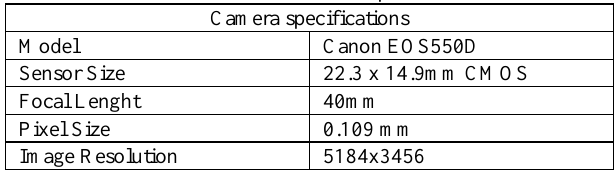
Table 2: Canon EOS550D specifications